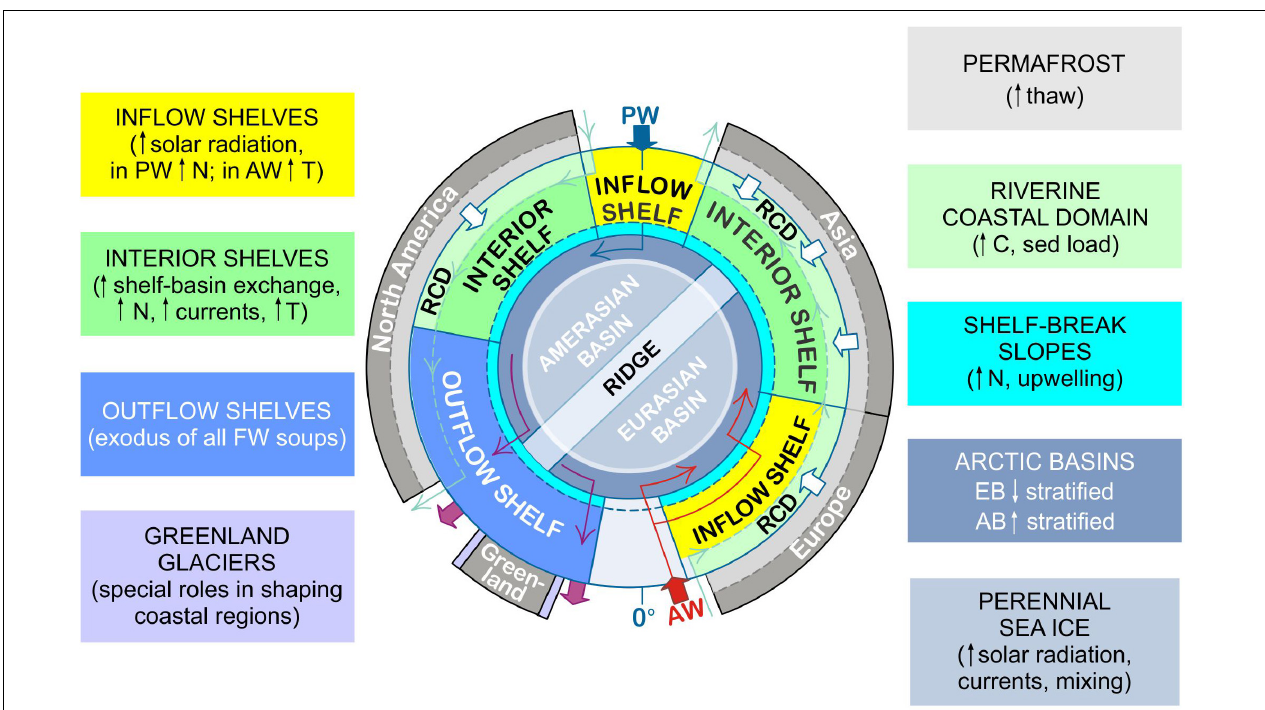
FIGURE 6 | Regional impacts of future freshwater change. Predicted future changes in freshwater inputs and warming will have differing regional impacts to the upper ocean across the hydromorphological domains as discussed in the text (section “Regionality”). For example, the interior basins are anticipated to experience increased (Amerasian Basin, AB) and decreased (Eurasian Basin, EB) stratification due to the redistribution of sea ice melt water from the EB into the AB. Central map as in Figure 1B